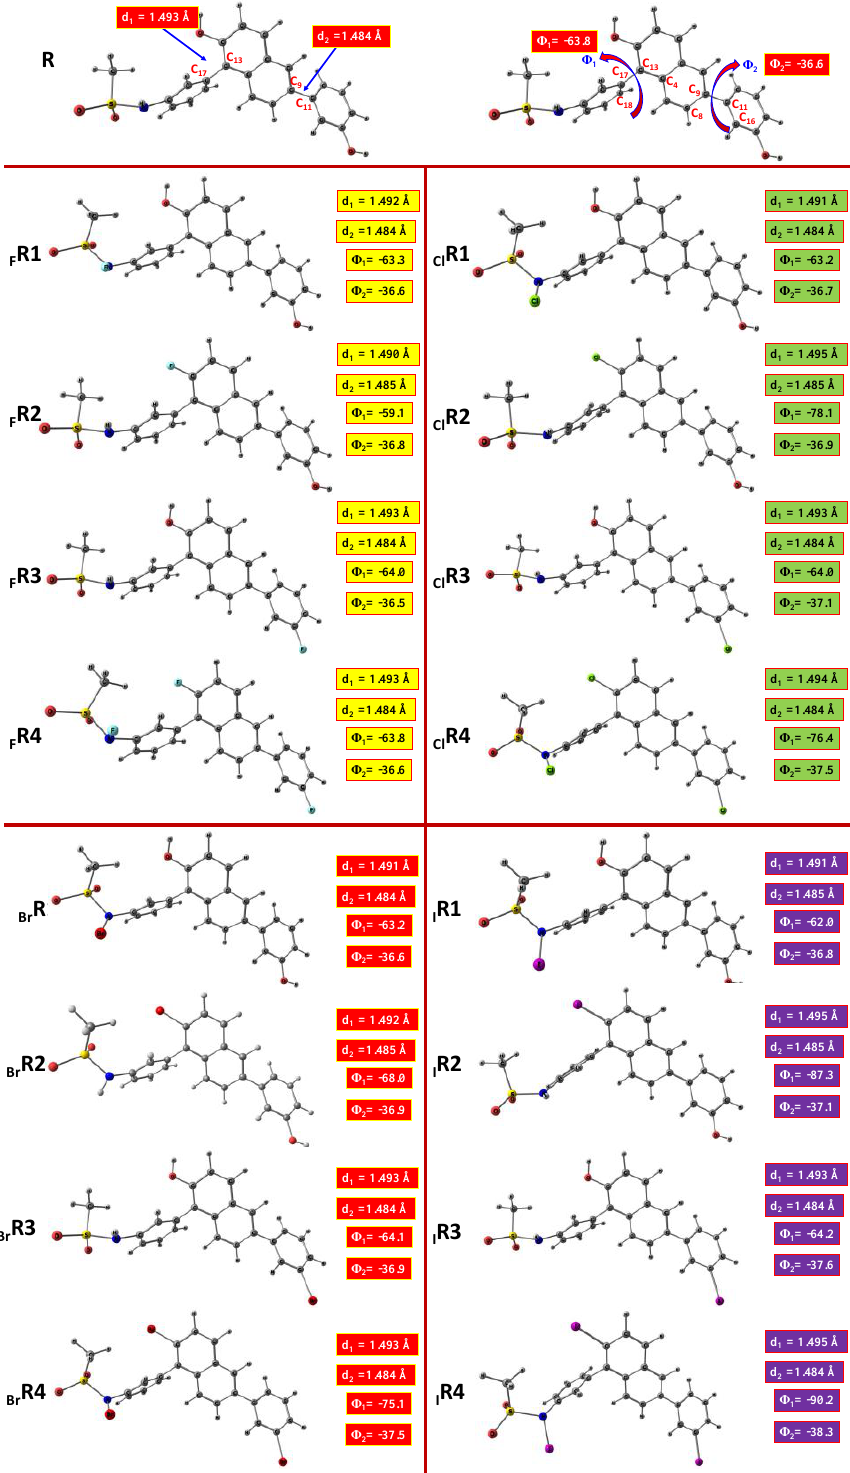
Figure 1. Computed optimized geometries of all molecules. (R = Reference molecule implies the distance (d1 and d2) between two carbon atoms and dihedral angles (Φ1 and Φ2) between four carbon atoms).